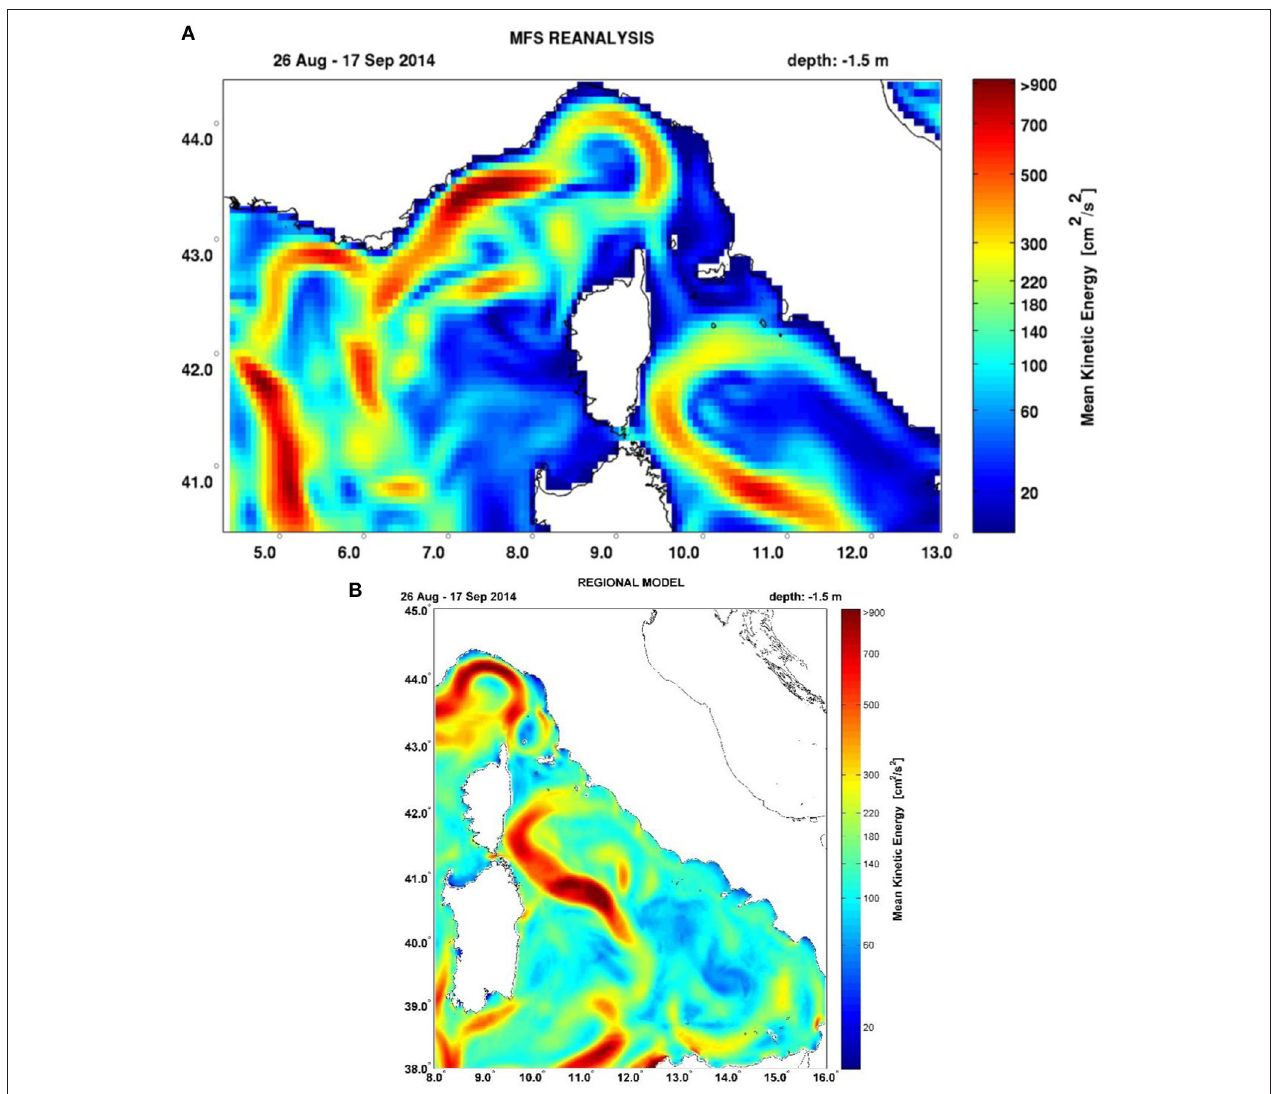
FIGURE 6 | Ocean circulation model and satellite data. (A) Mean Kinetic Energy (MKE) distribution from CMEMS, for the period 26 August-17 September 2014, which highlights the most energetic circulation patterns; (B) Mean MKE result from the Tyrreno-ROMS circulation model for the same period. Major differences between the Mediterranean CMEMS and the Tyrreno-ROMS model consist in improved representation of small scale hydrodynamic features.